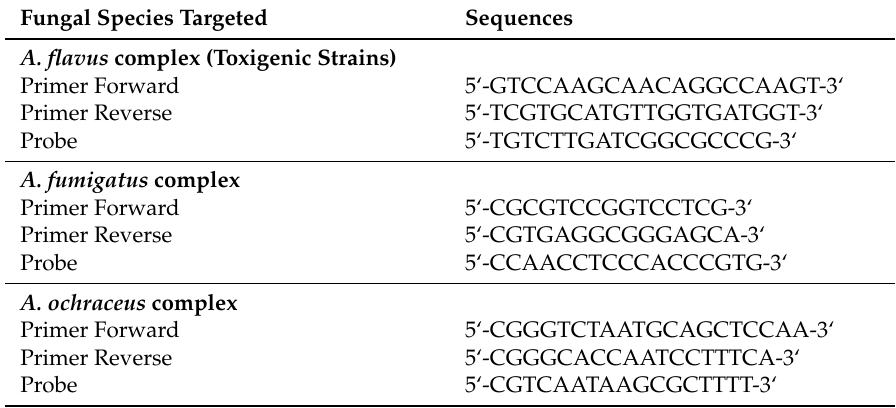
Table 3. Sequence of primers and TaqMan probes used for real-time